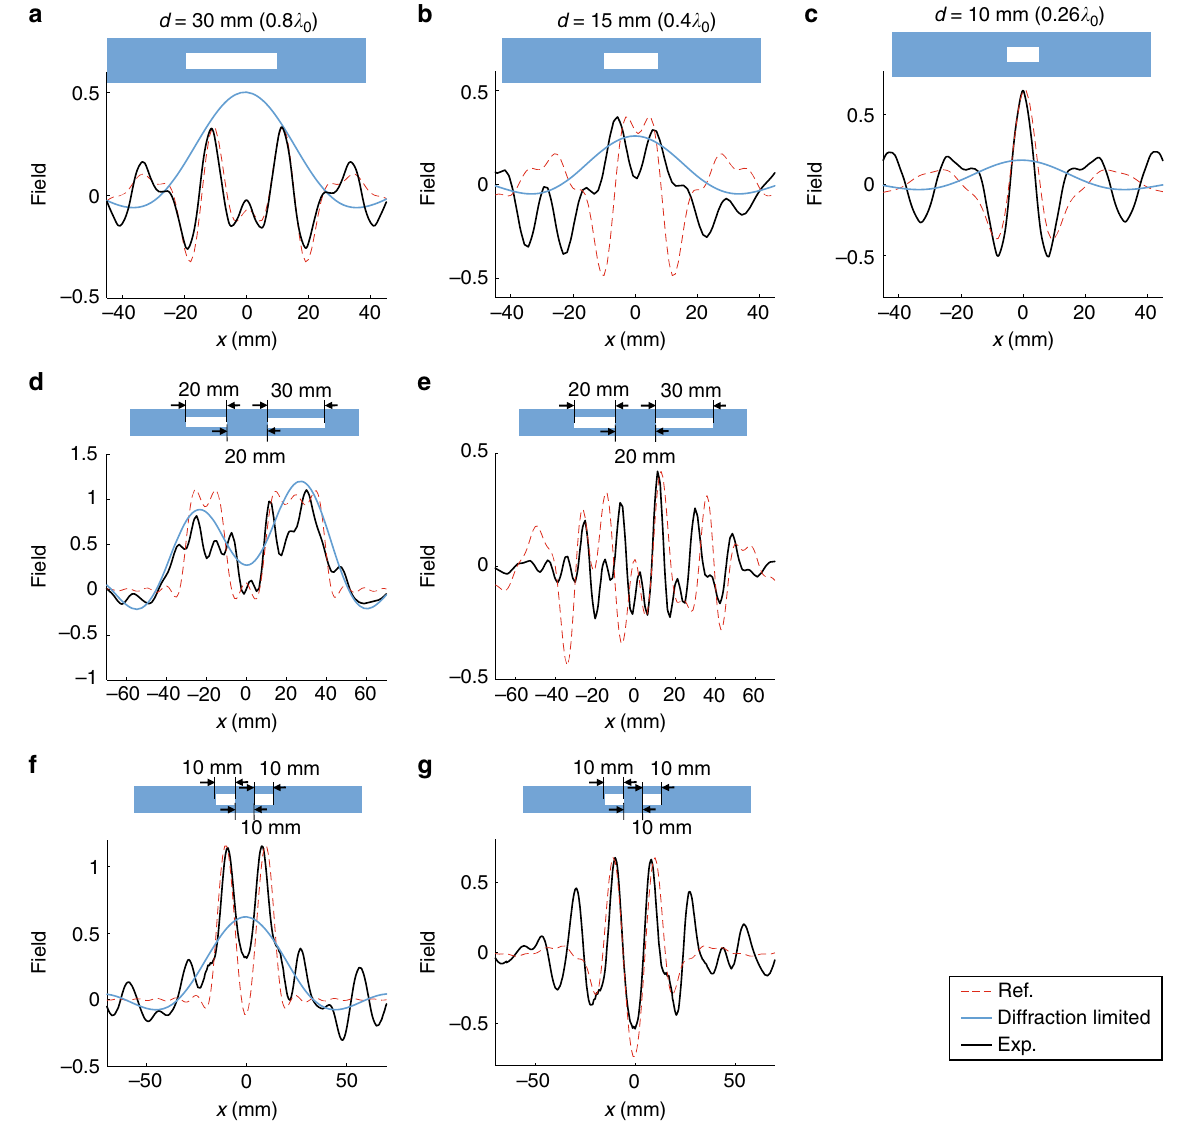
scanning points are obtained as I n ( x ), where n = 0, 1, 2, 3 (device number). Spatial Fourier transforms of I n ( x ) are obtained as S n ( k e ), n = 0, 1, 2, 3. The 1-D spatial Fourier transform of a rectangular function of 60mm width, S r ( k e ), is used as reference for normalization (plotted as red dashed lines in Figs. 6a – d). We nor- malize the amplitude of the measured spectrum S n ( k e ) to the amplitude of the reference S r ( k e ), and compensate for the phase variations of different wave vectors caused by passing through the system. Each S n ( k e ) is divided by the factor A n ¼ max j S n ð k e Þj e j ϕ n ð k e Þ , where max j S n ð k e Þj is the ratio of the maximum amplitudes of max j S r ð k e Þj max j S r ð k e Þj S